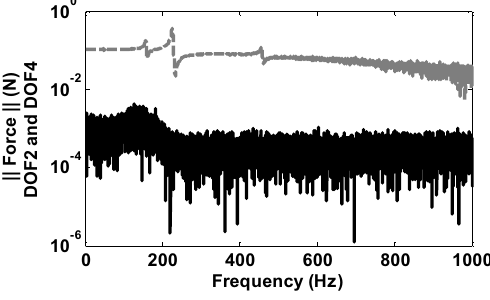
Fig. 7. Comparison of the force at DOF 2(——) and DOF 4 (– – –) for a damaging